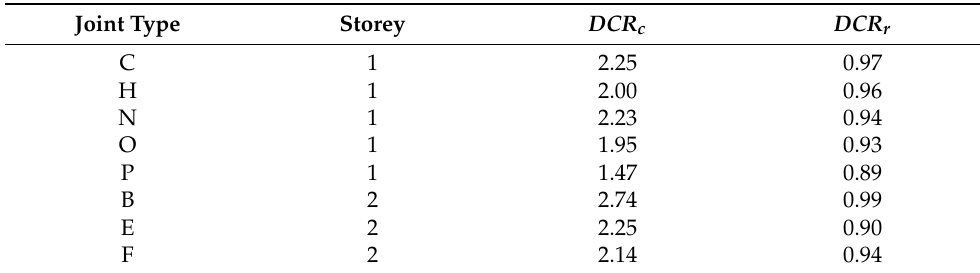
Table 5. Demand/capacity DCR ratios—selected beam-to-column